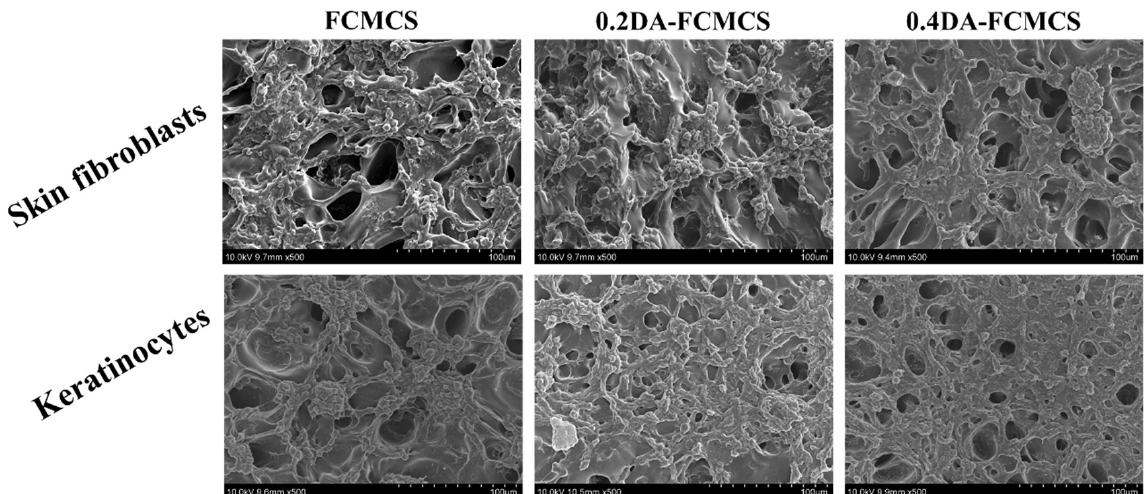
Figure 10. SEM images of skin fibroblasts and keratinocyte cells on FCMCS, 0.2DA-FMCS, and 0.4DA-FCMCS hydrogels.